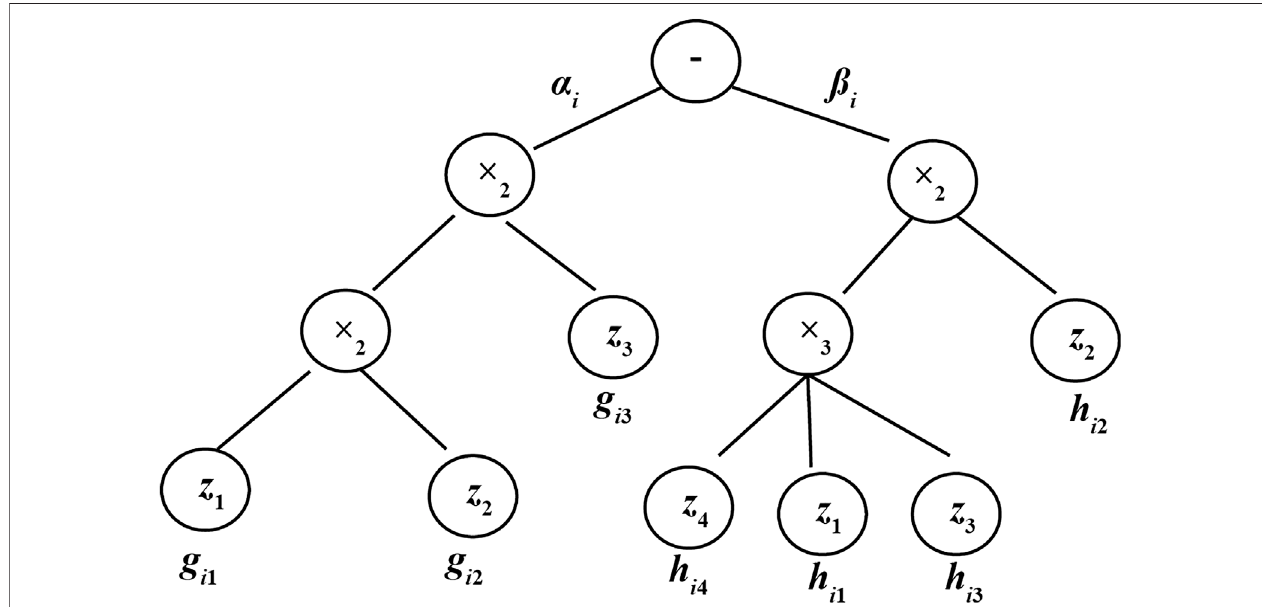
FIGURE 1 | Example of the chromosome of CVRAT.